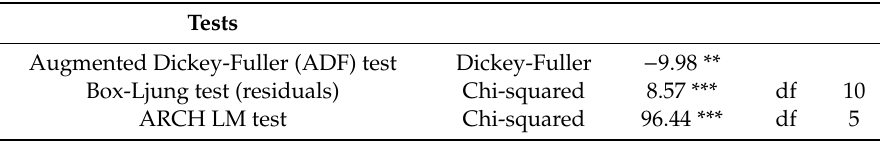
Table 2. Augmented Dickey-Fuller Test, Box-Ljung Test, and ARCH